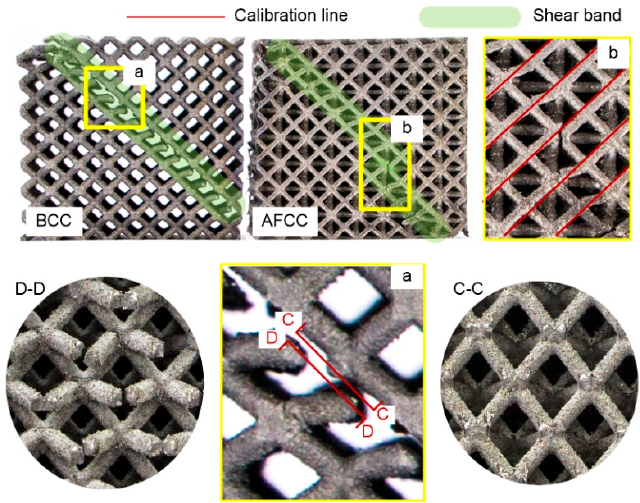
Figure 11. Sample failure graph of AFCC and BCC lattice structures: (a, C–C and D–D) partial enlargement of BCC structural failure; (b) partial enlargement of AFCC structural failure.